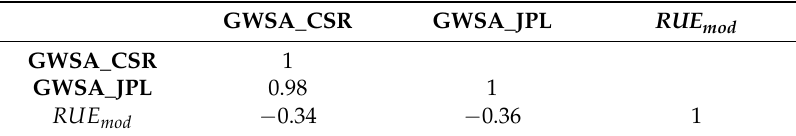
Table 3. Correlation between GWSA and RUE mod in Region C.